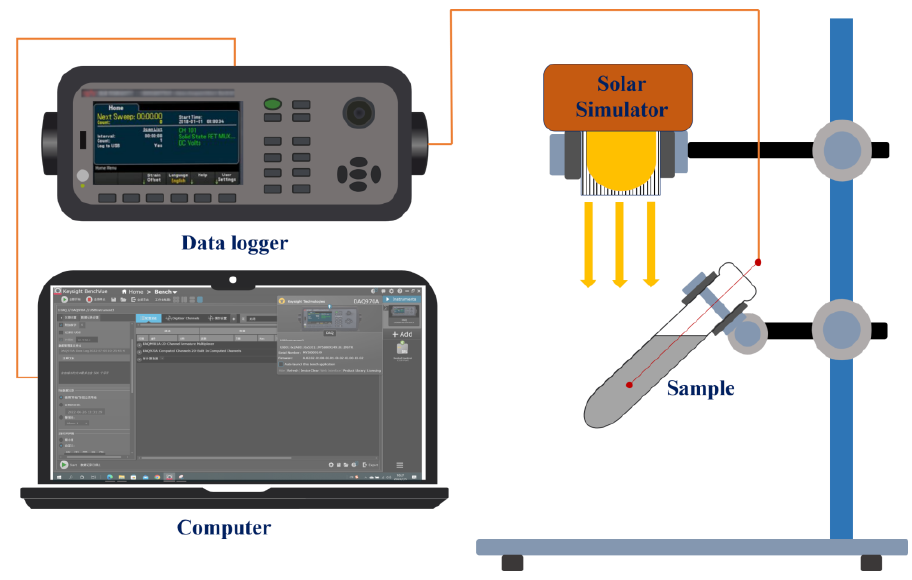
Figure 2. Schematic diagram of solar collector test set.